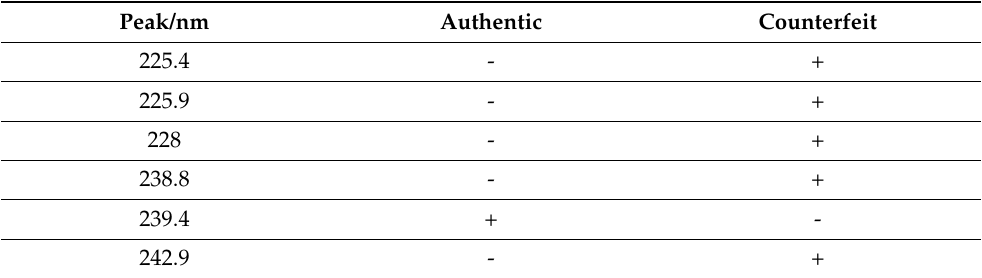
Table 2. List of main peaks which are missing in Zone A of the authentic 100 Euro banknote and present in the counterfeit (and vice versa).